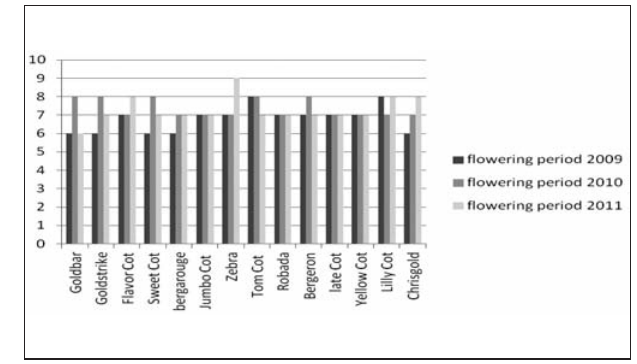
Fig. 4: Flowering periods 14 apricot varieties through 2009, 2010 and 2011